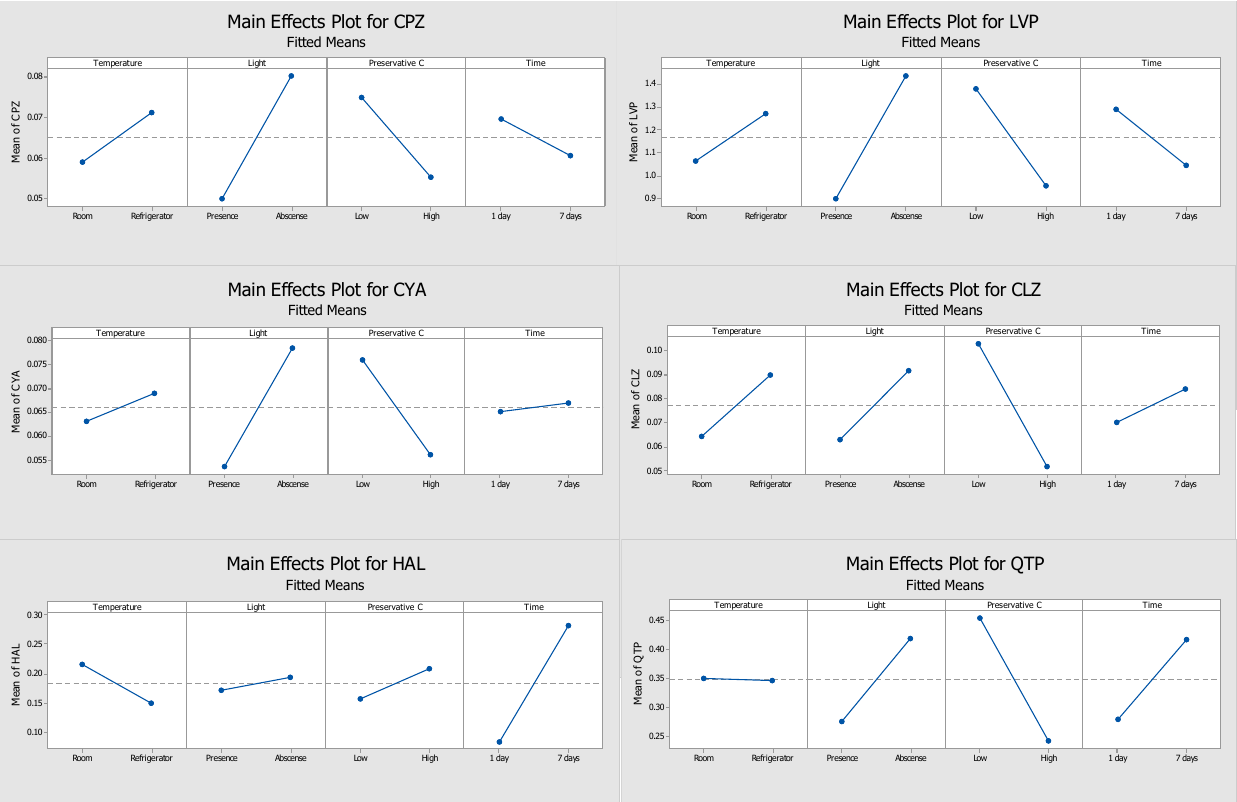
Figure 2. Main effects plots from ascorbic acid used as the preservative, which demonstrates the main factors in each parameter of each analyte (CPZ—chlorpromazine, LVP—levomepromazine, CYA—cyamemazine, CLZ—clozapine, HAL—haloperidol, QTP—quetiapine). The slope of the lines represents the effect of the response for the factors under study: temperature (25 ◦ C or 4 ◦ C), light (presence or absence), preservative concentration level (low or high), and storage time (1 or 7